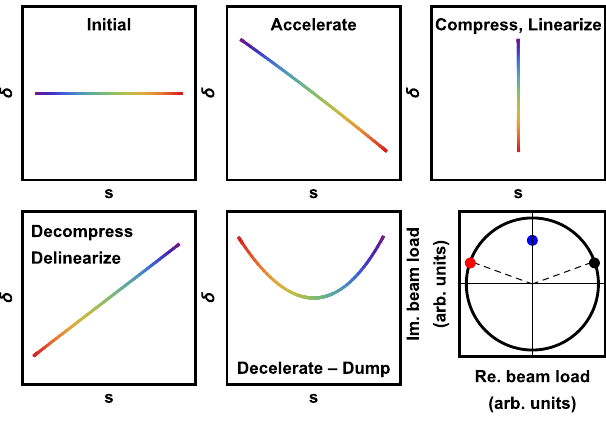
FIG. 15. Equivalent of Example IA shown in Fig. 4 but with utilization of a parasitic crossing and deceleration on opposite side of rf trough in order to remove linear chirp. This results in a large imaginary resultant rf load. We see residual curvature as the natural T 566 value of the arcs add to the rf curvature for deceleration on falling side of trough. rf beam load plot shows phase choices during acceleration (black), deceleration (red), and resultant